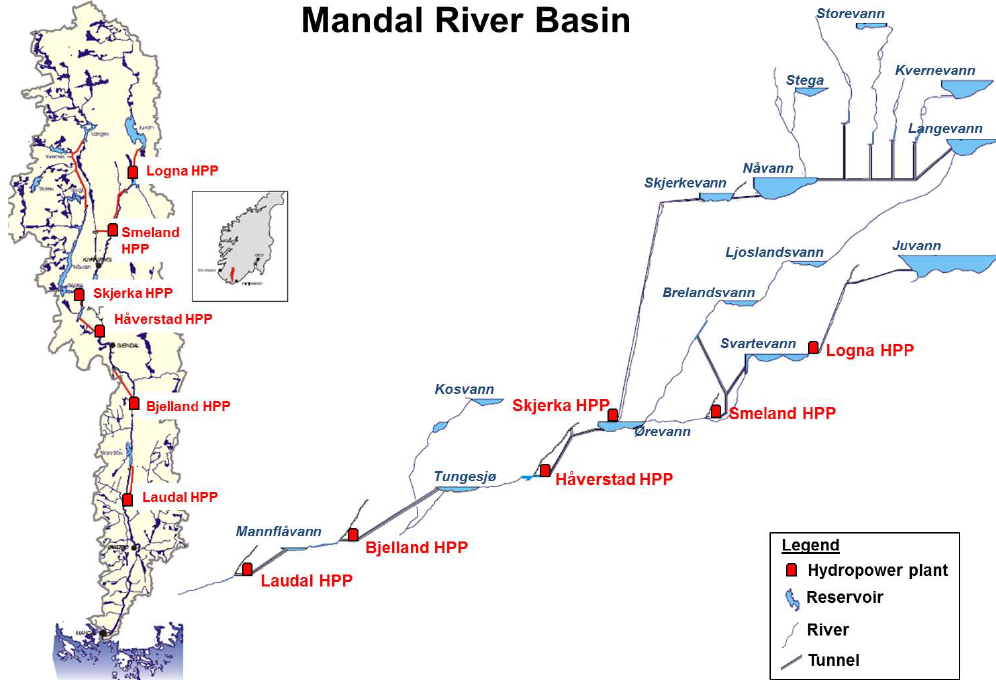
Fig. 4. Schematically view of Mandal River basin, including reservoirs and power plants. Modified from Agder Energi (2013).